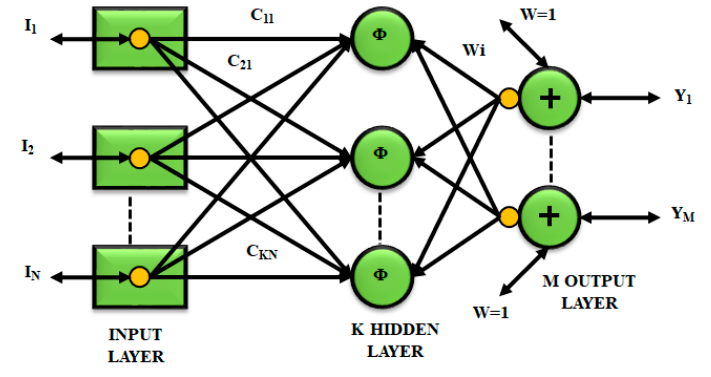
Figure 7. Topology of radial basis function neural network (RBFNN).